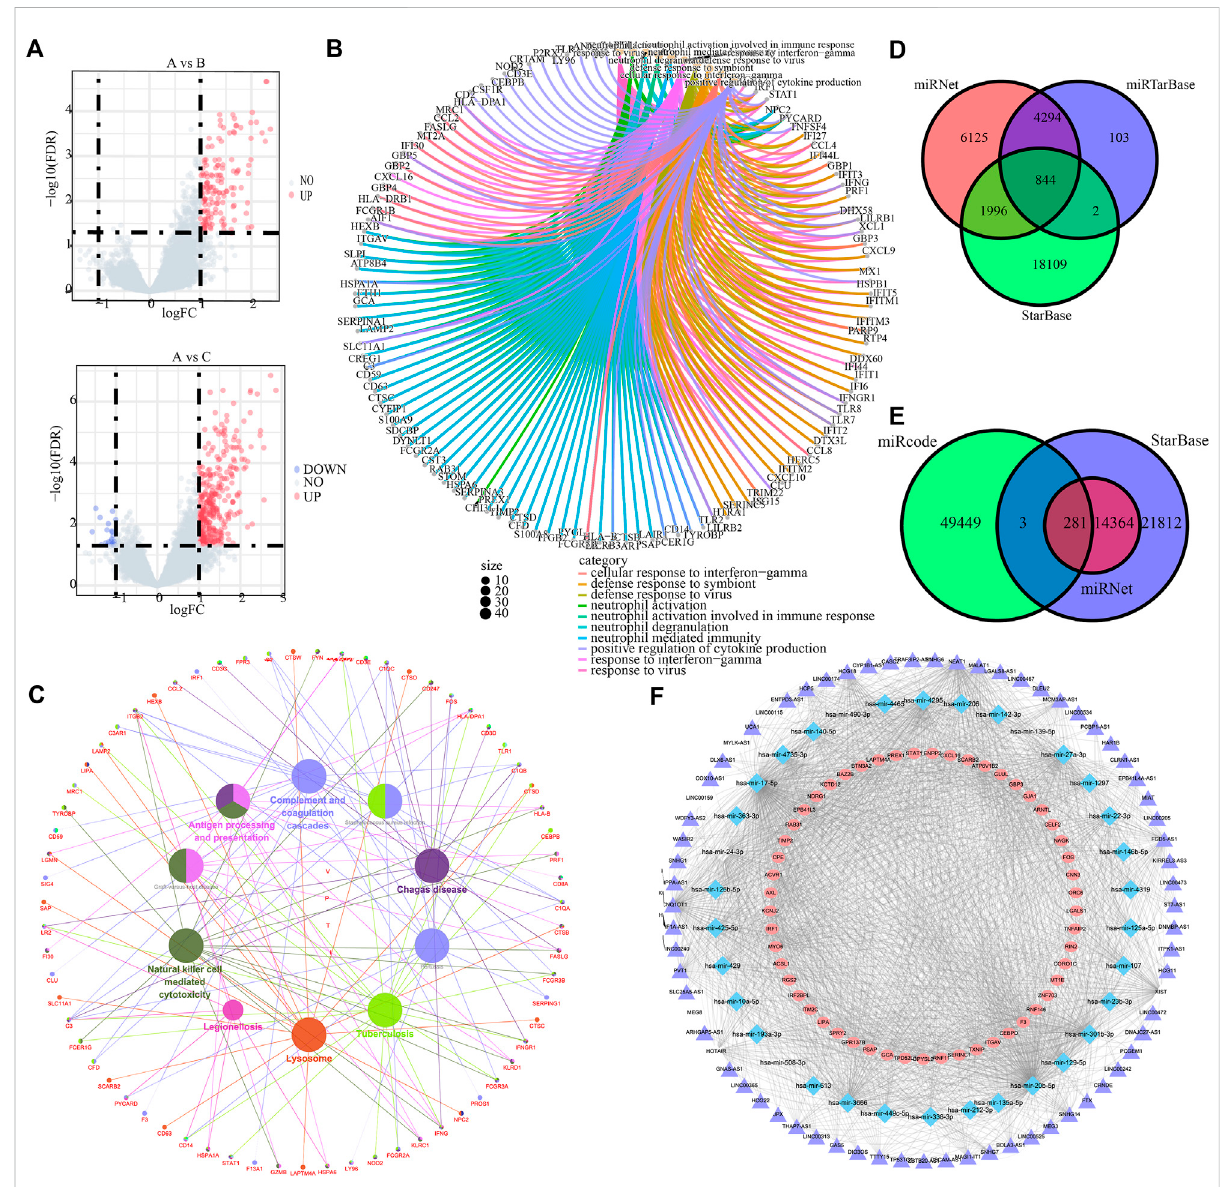
FIGURE 4 ICI differential genes and associated ceRNAs. (A) Volcano maps based on the distribution of all genes in clusterA and clusterB, clusterA and clusterC. (B) GO enrichment analysis for the top 10 most signi fi cant biological functions. (C) Cytoscape differential gene KEGG enrichment analysis. (D) mrna-mirna relationship pairs predicted by miRNet, miRTarBase and StarBase databases. (E) Predicted lncRNAs from miRNet, StarBase and mircode databases. (F) mrna-mirna-lncrna regulatory